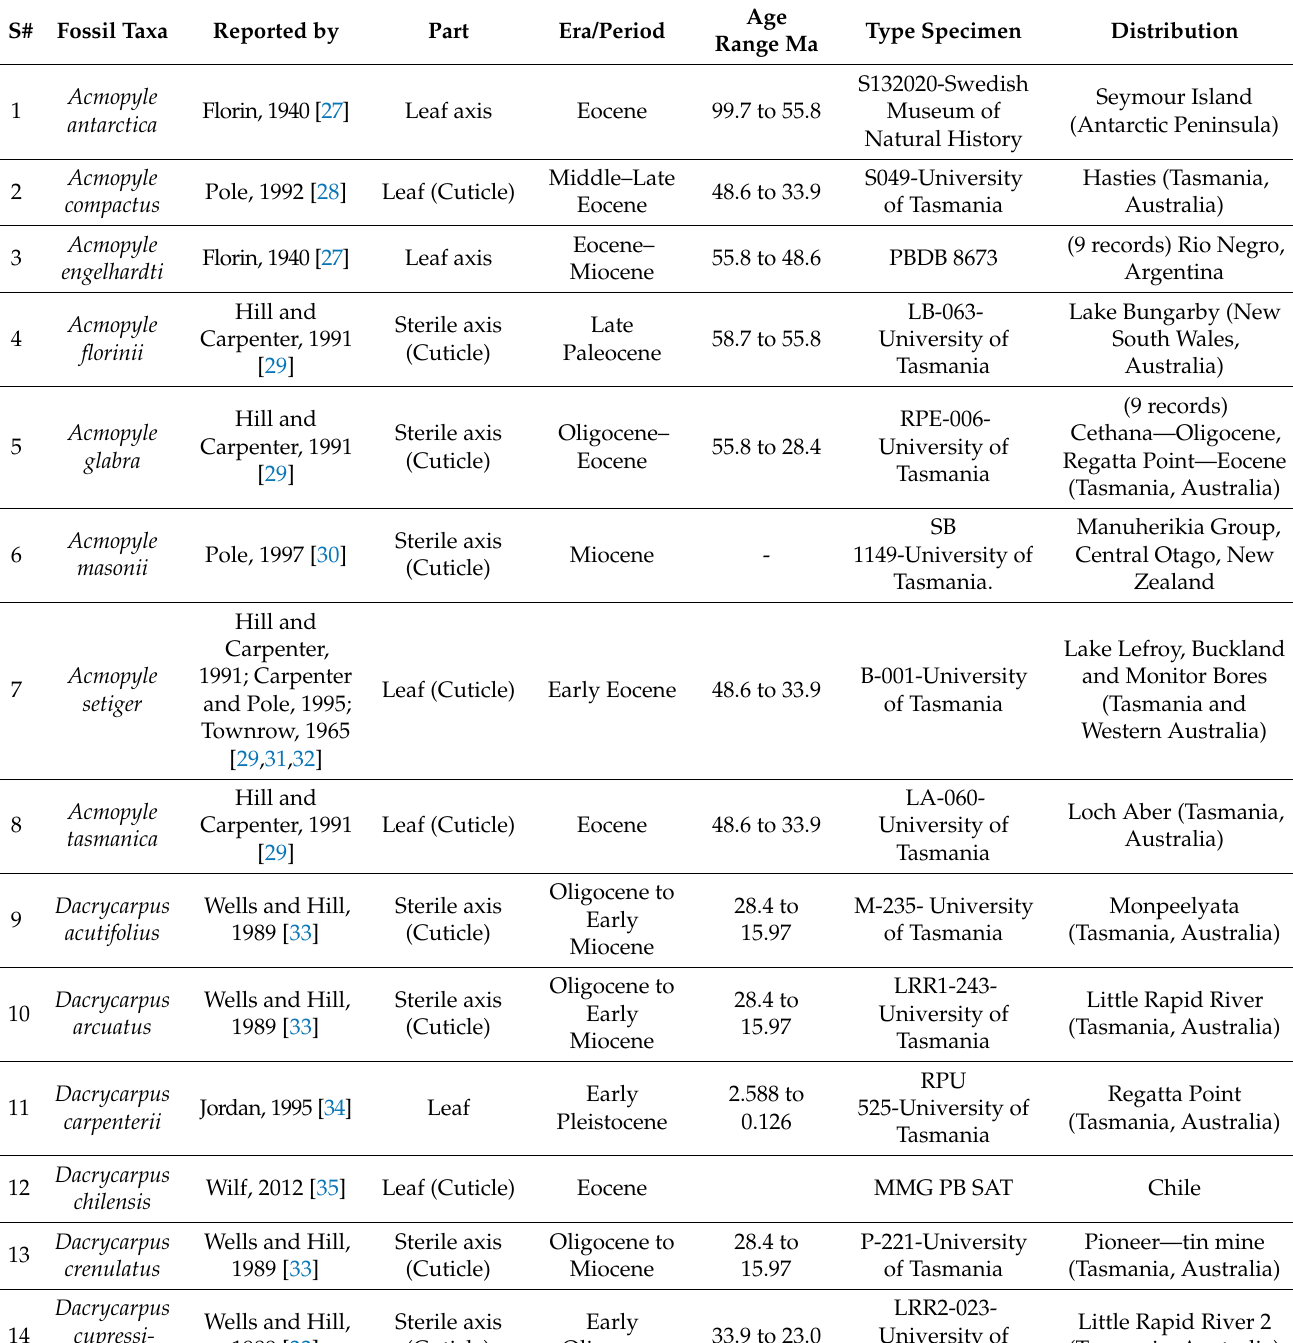
Table 2. An updated checklist of podocarps fossil species of extant